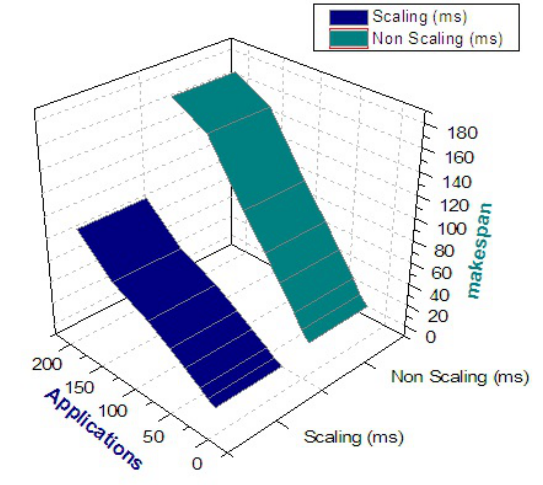
Figure 18. Makespan with different applications.